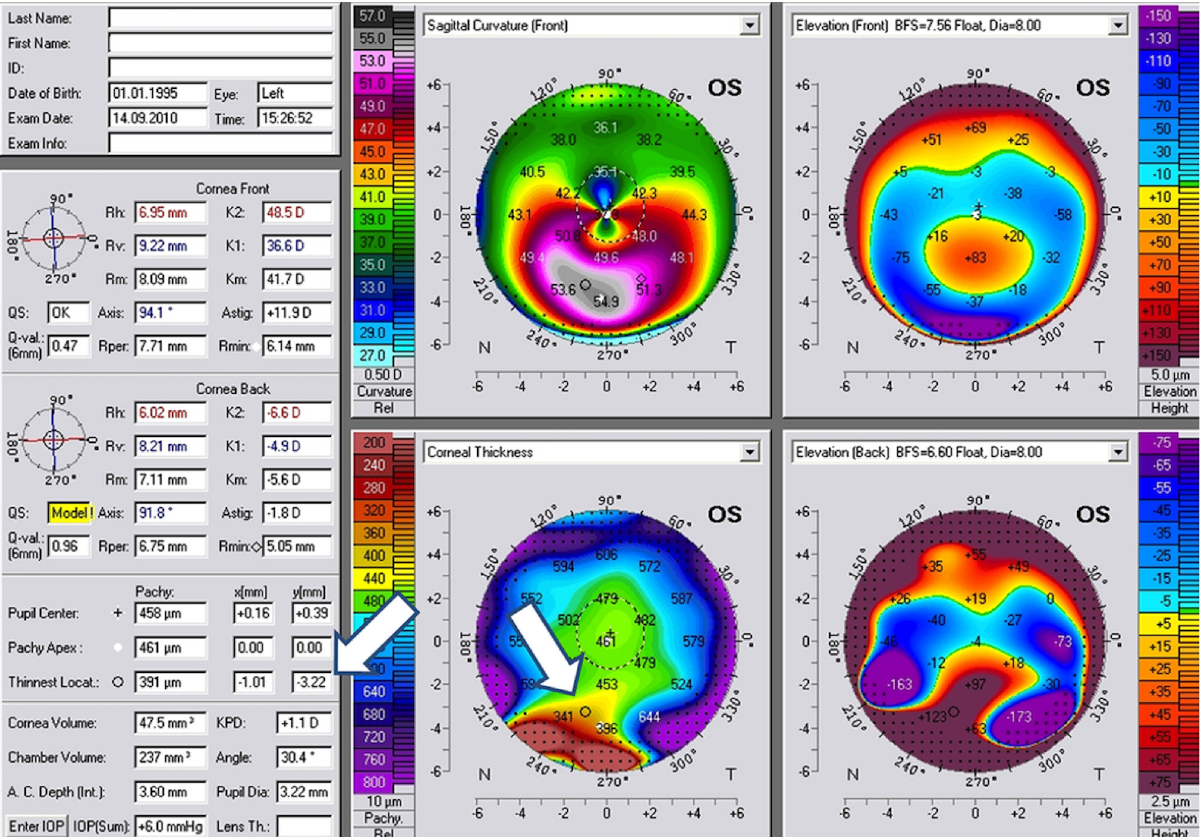
Figure 8. A case of severe PMD. The thinnest location is largely inferiorly displaced (white